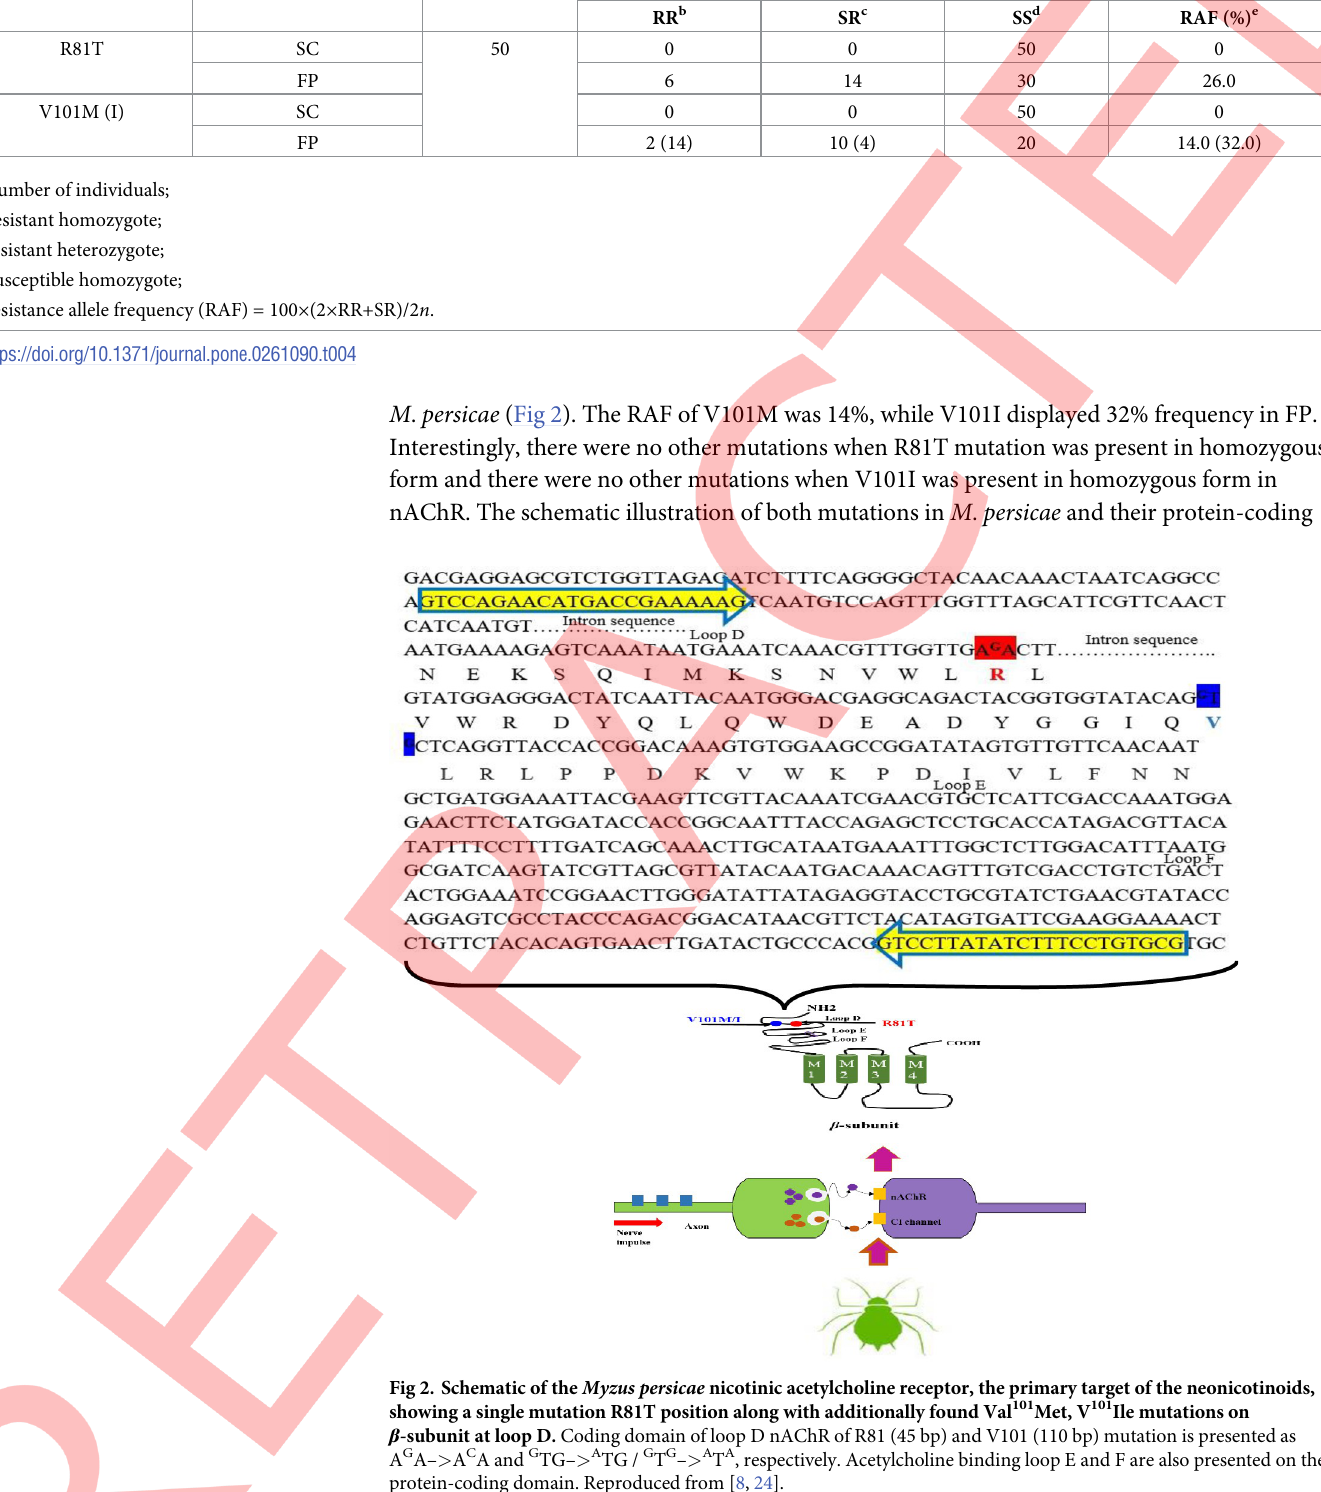
Table 4. Genotype and allelic frequencies of the R81T mutation in susceptible clone (SC) and field population (FP) of Myzus persicae . Mutation